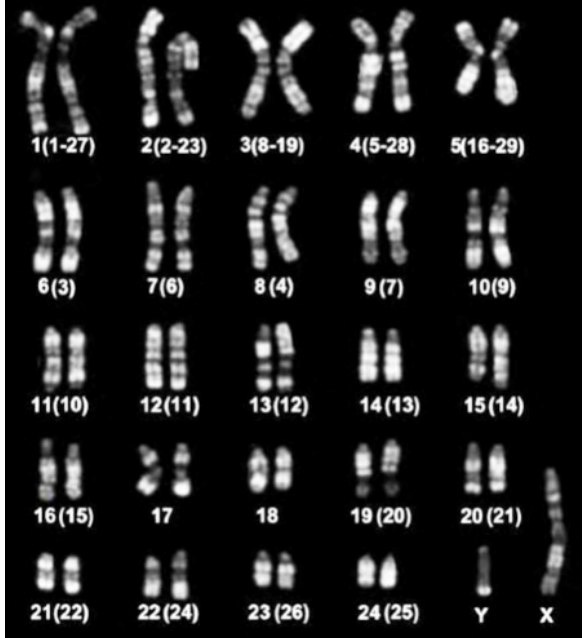
Figure 5. RBA-banded river buffalo karyotype is arranged according to the standard river buffalo karyotype [47]. The numbers between parentheses are referred to as the cattle homologous chro- mosomes, according to ISCNDB2000,